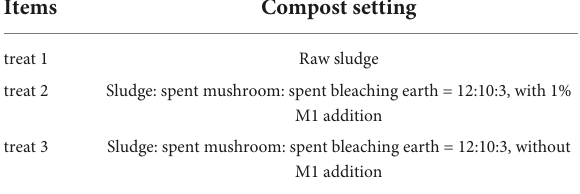
TABLE 1 Compost method